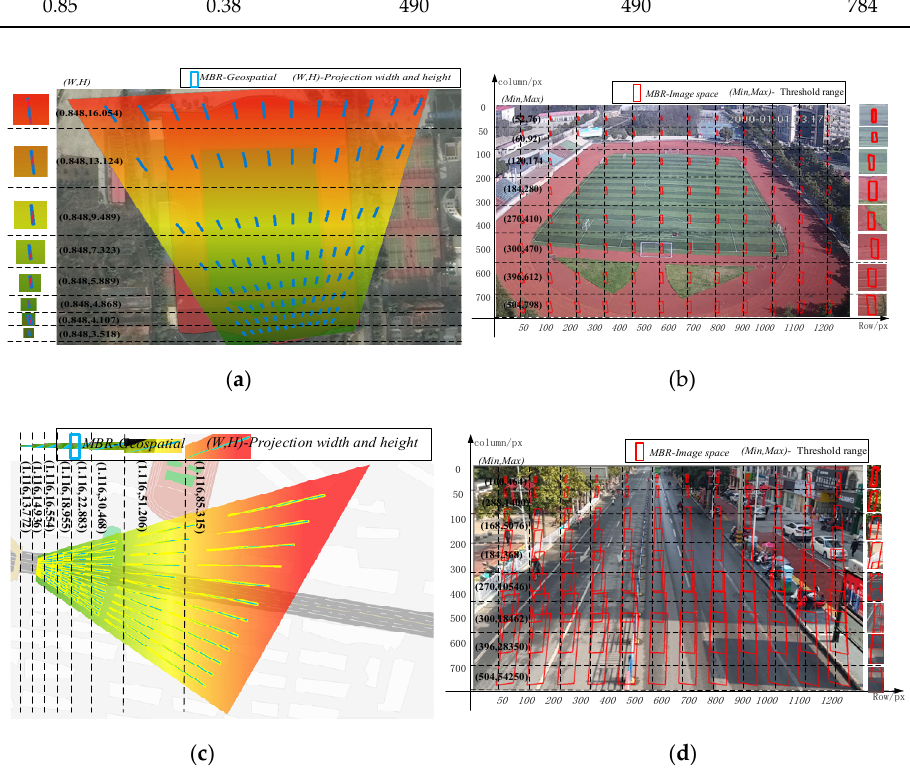
Figure 9. Threshold calculation of videos #1 and #2 in image space: ( a ) object size projected on the geographical space of video #1 and ( b ) image space threshold of video #1. ( c ) Object size projected on the geographical space of video #2 and ( d ) image space threshold of video #2. Table 2. Threshold information of videos #1 and #2.